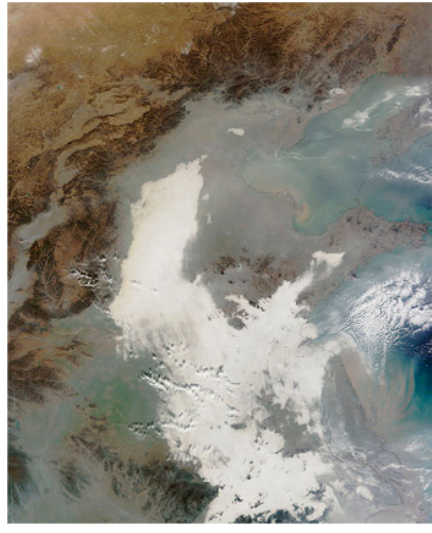
Figure 2 . Eastern China smog Figure 2. Eastern China